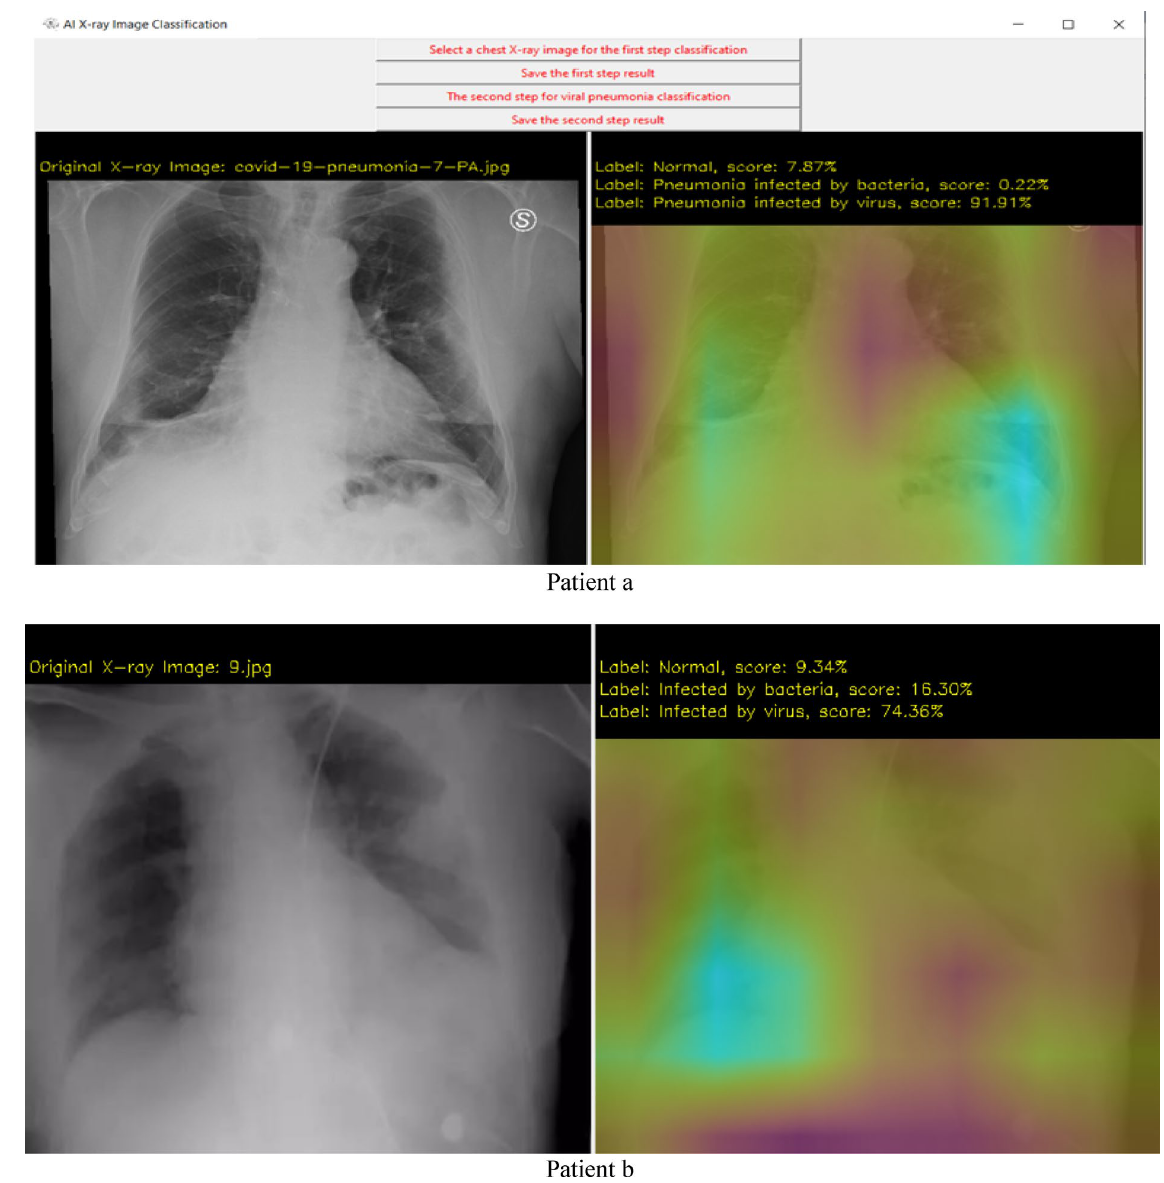
Figure 4. First step